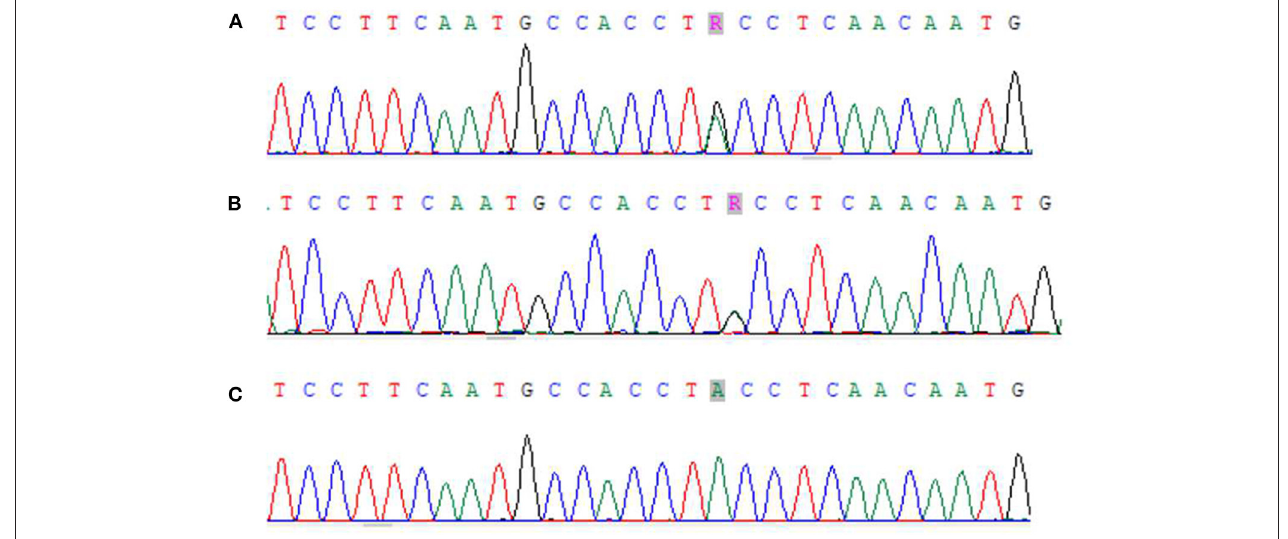
FIGURE 1 | Next-generation sequencing results of zhou xx and his parents. (A) Zhou xx - Father ITGB3 exon9:c.1199G > A showed G/A heterozygosity. (B) Zhou xx - mather ITGB3 exon9:c.1199G > A showed G/A heterozygosity. (C) Zhou xx - ITGB3 exon9:c.1199G > A showed G/A